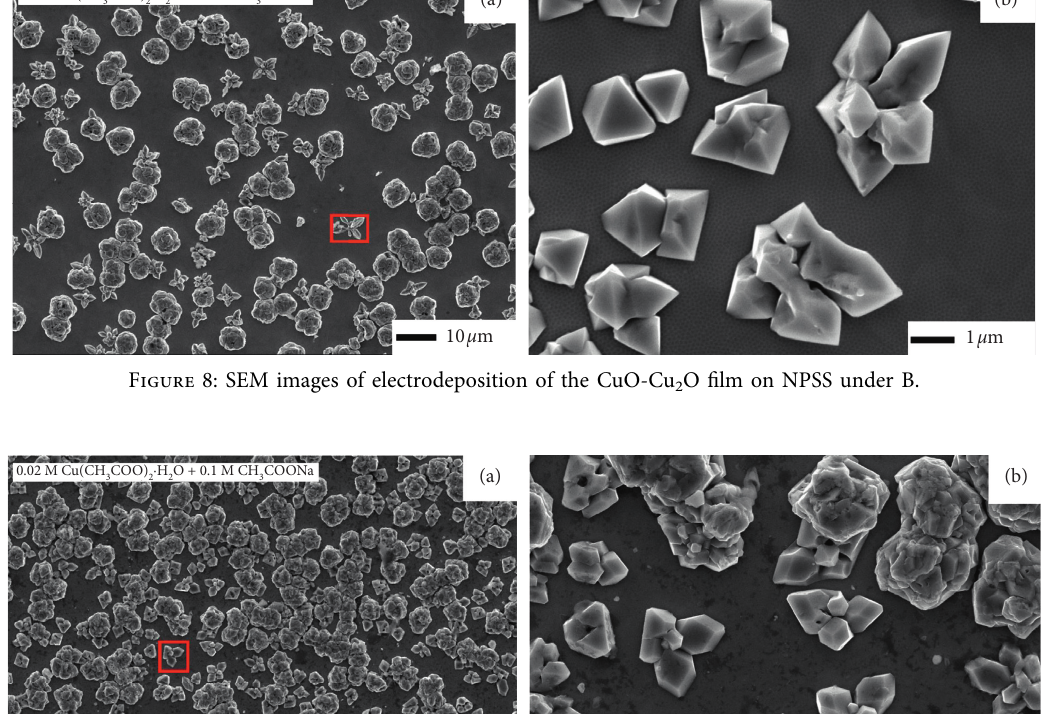
2 O film on NPSS under